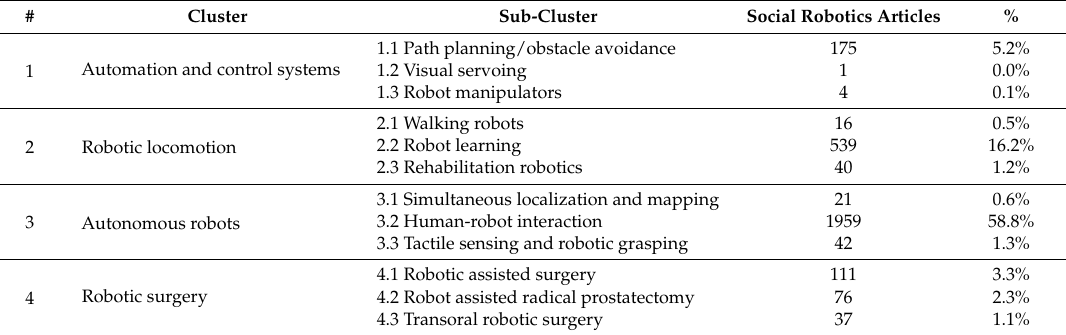
Table 5. Participation of social robotics articles in the sub-clusters of the robotics network.